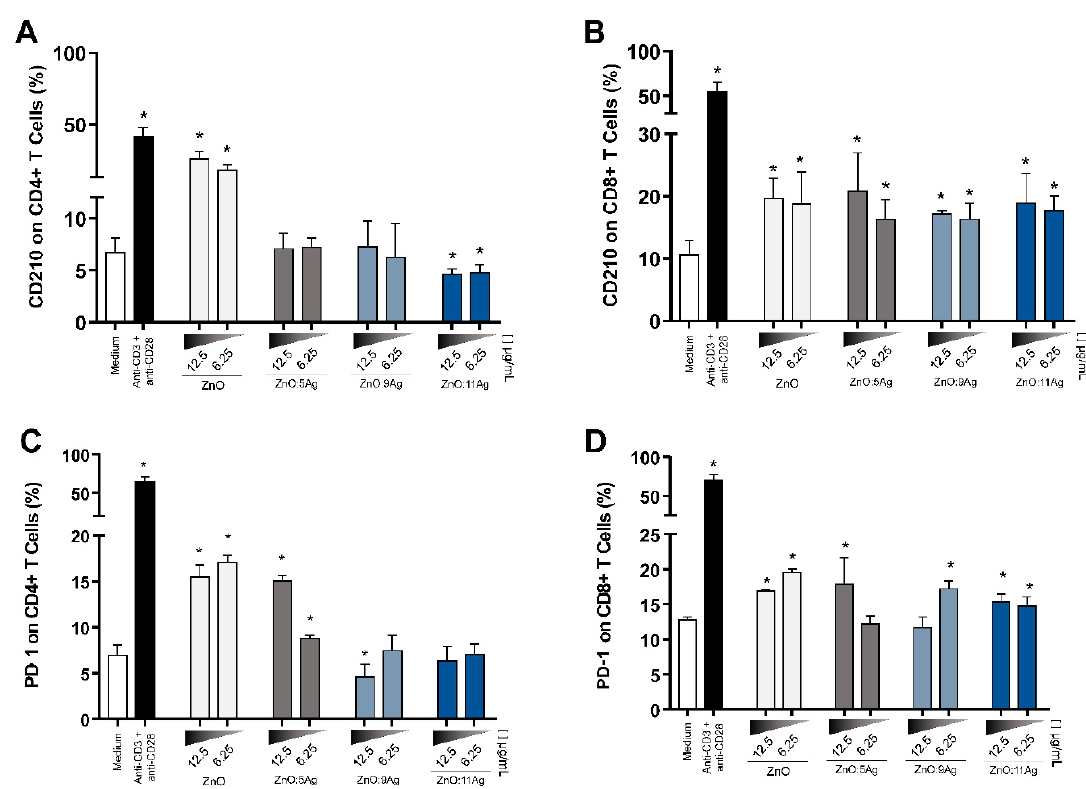
Figure 6. NPCs differentially impact the expression of CD210 and PD-1 in T lymphocytes. Expression of CD210 (Figure 5A,B) and PD-1 (Figure 5C,D) was performed by flow cytometry on CD4+ and CD8+ T lymphocytes from PBMCs treated for 72 h, and these results are expressed as the mean fluorescence intensity ± SEM. The Mann–Whitney test was applied, and values of p < 0.05 (*) were considered significant when compared to cell culture without treatment (medium). Cells without treatment (medium) and cells treated with anti-CD3 and anti-CD28 stimuli were used as negative and positive controls, respectively. ( A ) ZnO nanocrystals increased CD4+ 210+ T cells in cultures when ZnO:11Ag NCPs were added. ( B ) In CD8+ T lymphocytes, all treatments upregulated the expression of CD210. ( C ) CD4+ T cells treated with ZnO nanocrystals and ZnO:5Ag NCPs increased the expression of PD1, while ZnO:9Ag NCPs downregulated this expression. ( D ) All tested nanoformulations increased PD-1 expression in CD8+ T lymphocytes but in a dose-dependent